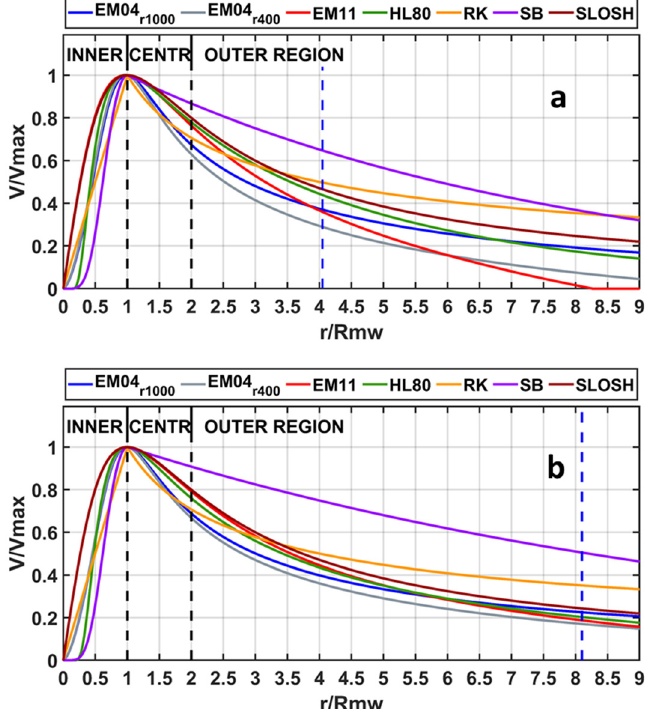
Figure 2. Comparison of normalized wind profiles for different parametric models: ( a ) Katrina on 26 August 2005 at 12:00 UTC (Category 1) with V max = 38.58 m/s, Δ P = 32 mb, R mw = 37.04 km, latitude = 25.1°; and ( b ) Rita on 22 September 2005 at 6:00 UTC (Category 5) with V max = 56.59 m/s, Δ P = 113 mb, R mw = 37.04 km, latitude = 24.8°. R o = 1000 km is considered in both cases. Blue dashed line shows the position of r = 150 km. Table 3. Relative wind speed ( V/V max ) percent decay at different relative radius ( r/R mw ). r/R mw